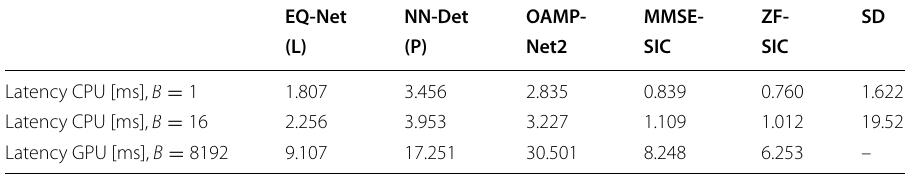
Table 1 Latency benchmarks of soft-output MIMO detection algorithms for a 4 × 4 , 16-QAM scenario